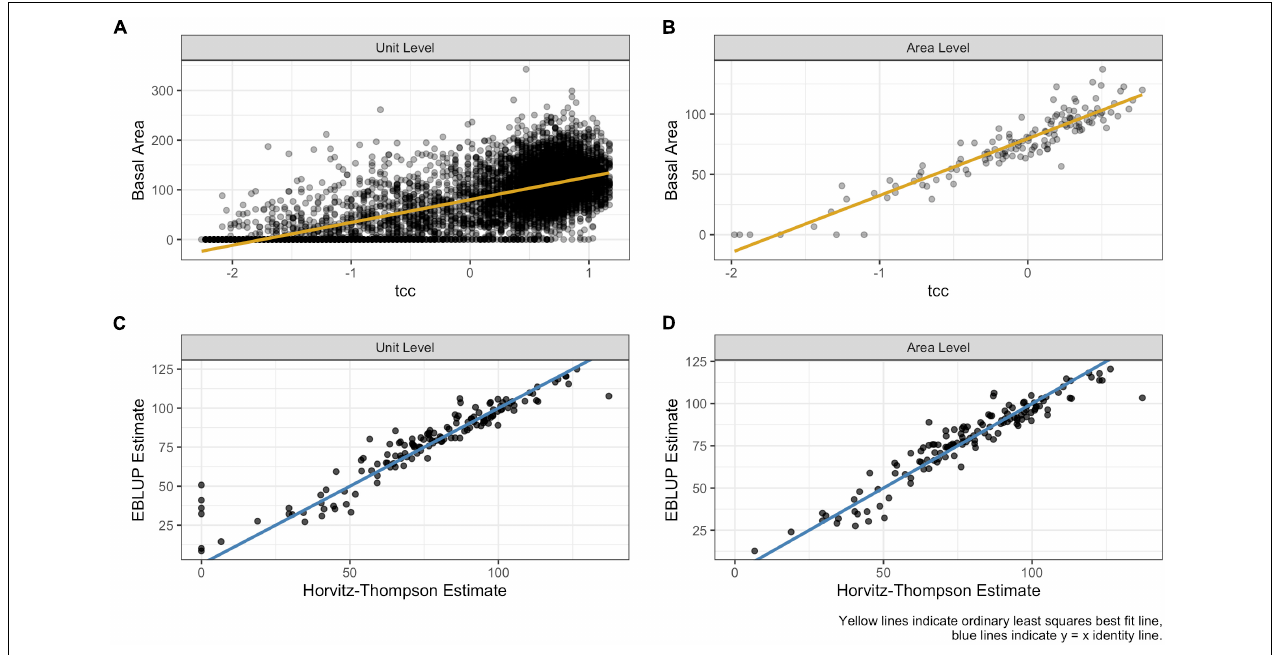
FIGURE 9 | The relationship between a response variable (basal area) and a predictor variable (total canopy cover, “tcc”). (A) Depicts the relationship between basal area and tcc at the unit level for province M221 with counties as the national dataset. (B) Depicts the relationship between the same variables, in the same province and with the same national dataset, but at the area level. (C) Unit and (D) area-level EBLUP estimates compared to the Horvitz–Thompson estimates in province M221 for the county domains. On plots (A,B) , the yellow line indicates the ordinary least squares best fit line and on plots (C,D) the blue line is the identity line.